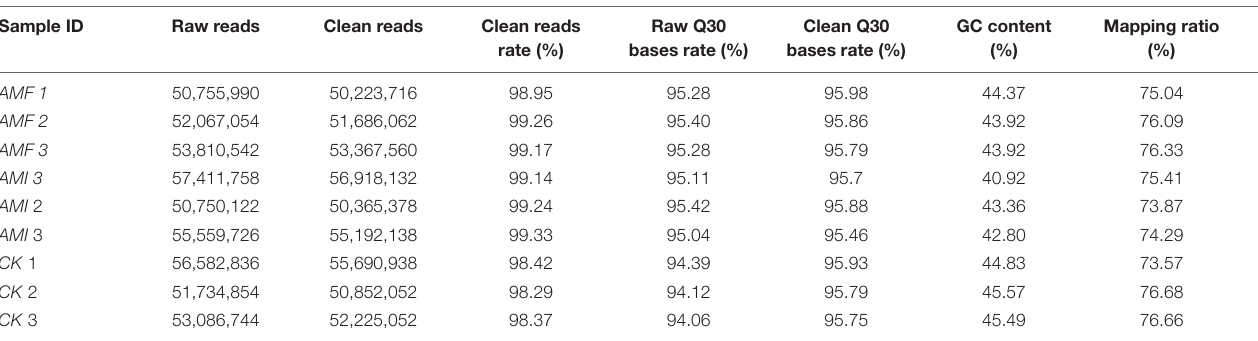
FIGURE 1 | Nutrient acquisition of B. tripartita on nitrogen (N) (A) and phosphorus (P) (B) ; N/P ratio of B. tripartita seedlings (C) . AMF = arbuscular mycorrhizal (AM) fungi inoculation treatment; AMI = AM fungi inoculation combining with indigenous microorganisms treatment; CK = the control without AM fungi and indigenous microorganisms. The different lowercase letters (a, b, and c) above the column indicate significant differences between AMF , AMI , and CK ( P < 0.05). The dashed lines indicate the N/P ratio equal to 14 and equal to 16, respectively. TABLE 2 | Results of RNA sequencing and